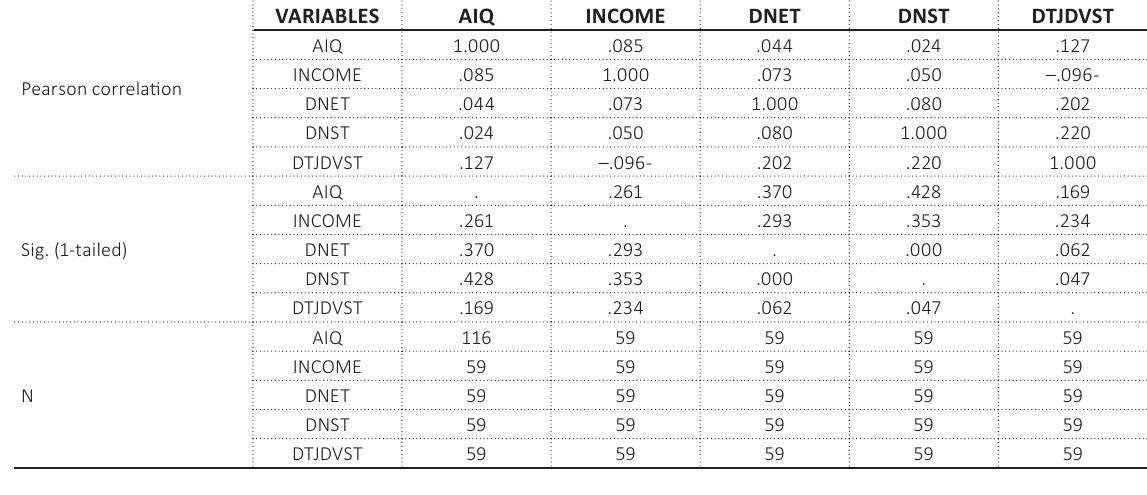
Pearson correlation